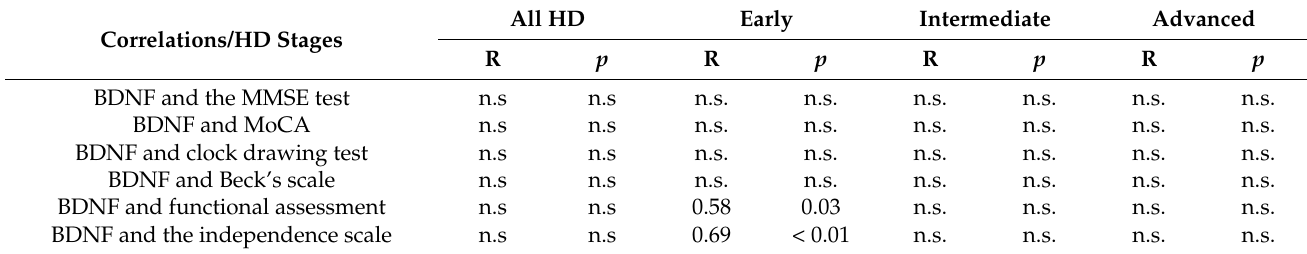
Table 4. Correlations between plasma levels of BDNF and neuropsychological assessment determined using Spearman’s test. All HD Early Intermediate Correlations/HD Stages